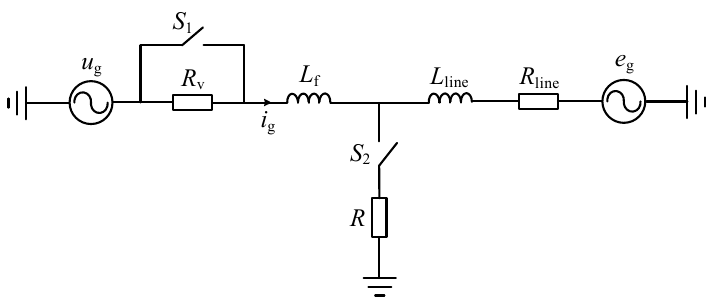
Figure 4. Equivalent circuit diagram of the grid-connected wind turbine system during the three- phase short-circuit fault.